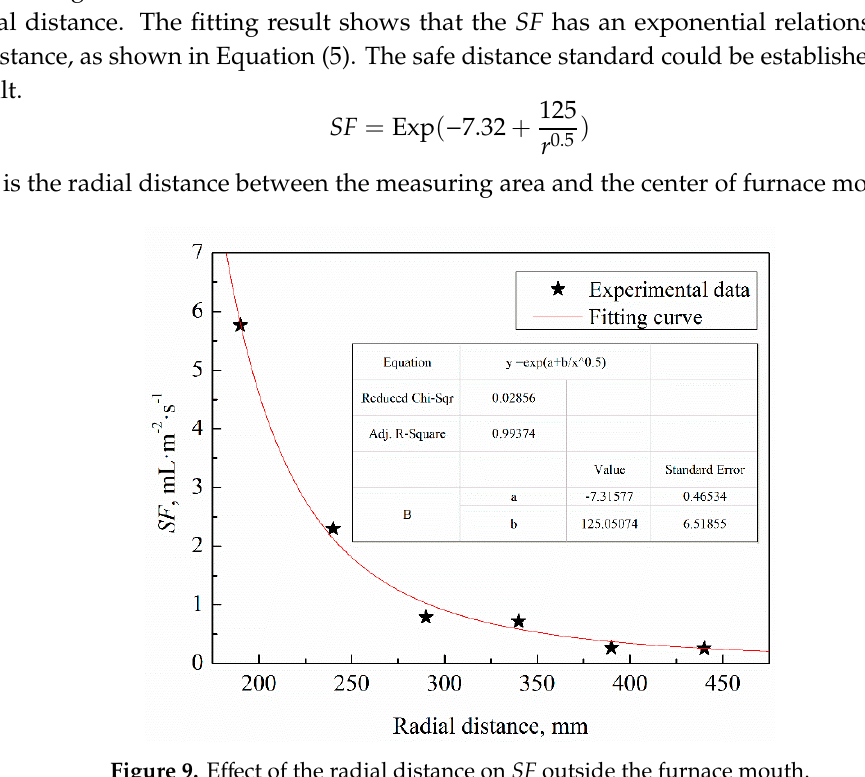
Figure 9. E ff ect of the radial distance on SF outside the furnace Figure 9. Effect of the radial distance on SF outside the furnace mouth.